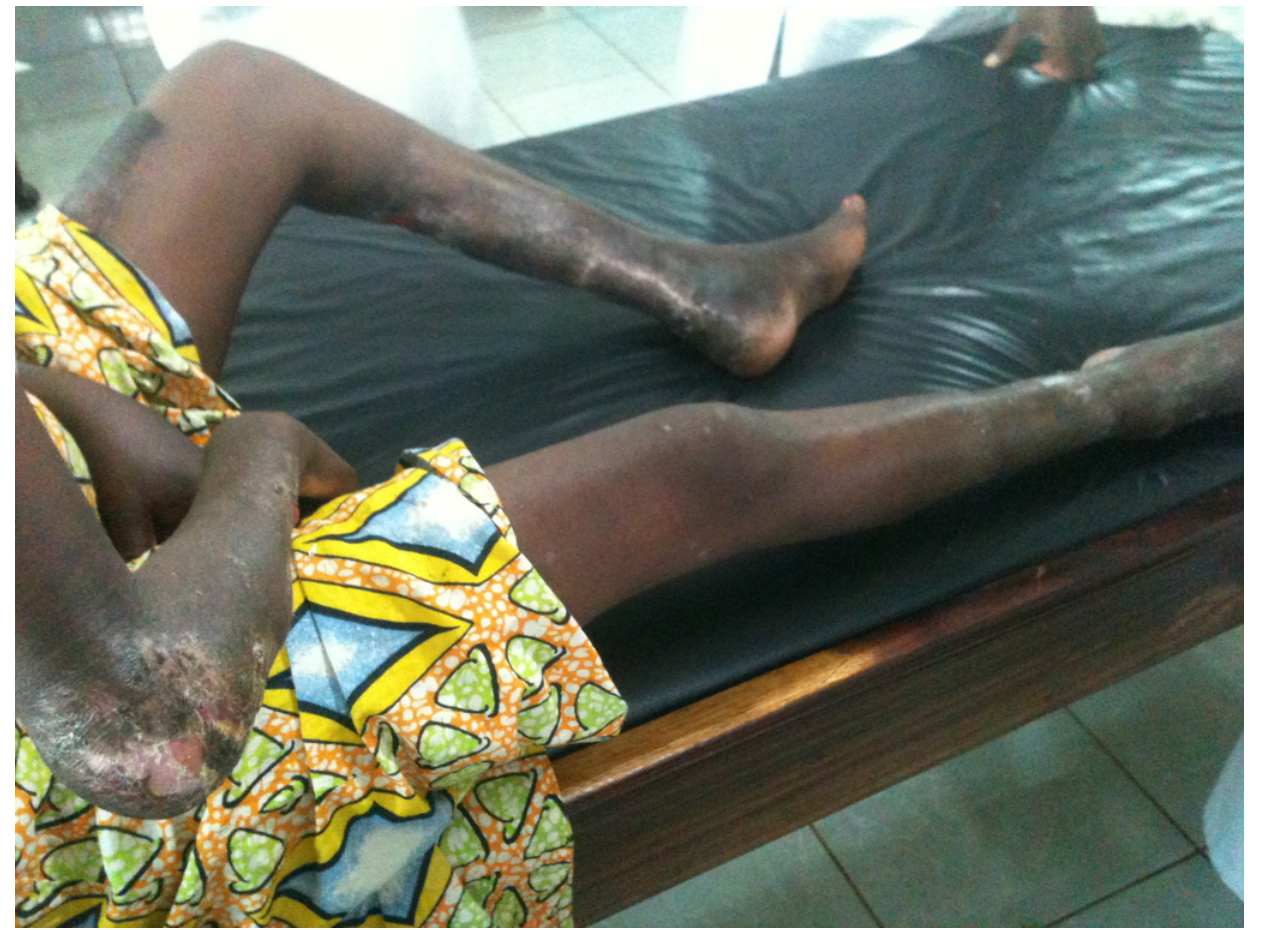
Fig 3. Image illustrating the severity of lesions in Buruli ulcer-HIV coinfected individuals; a woman with ulcers on her right elbow and both ankles.